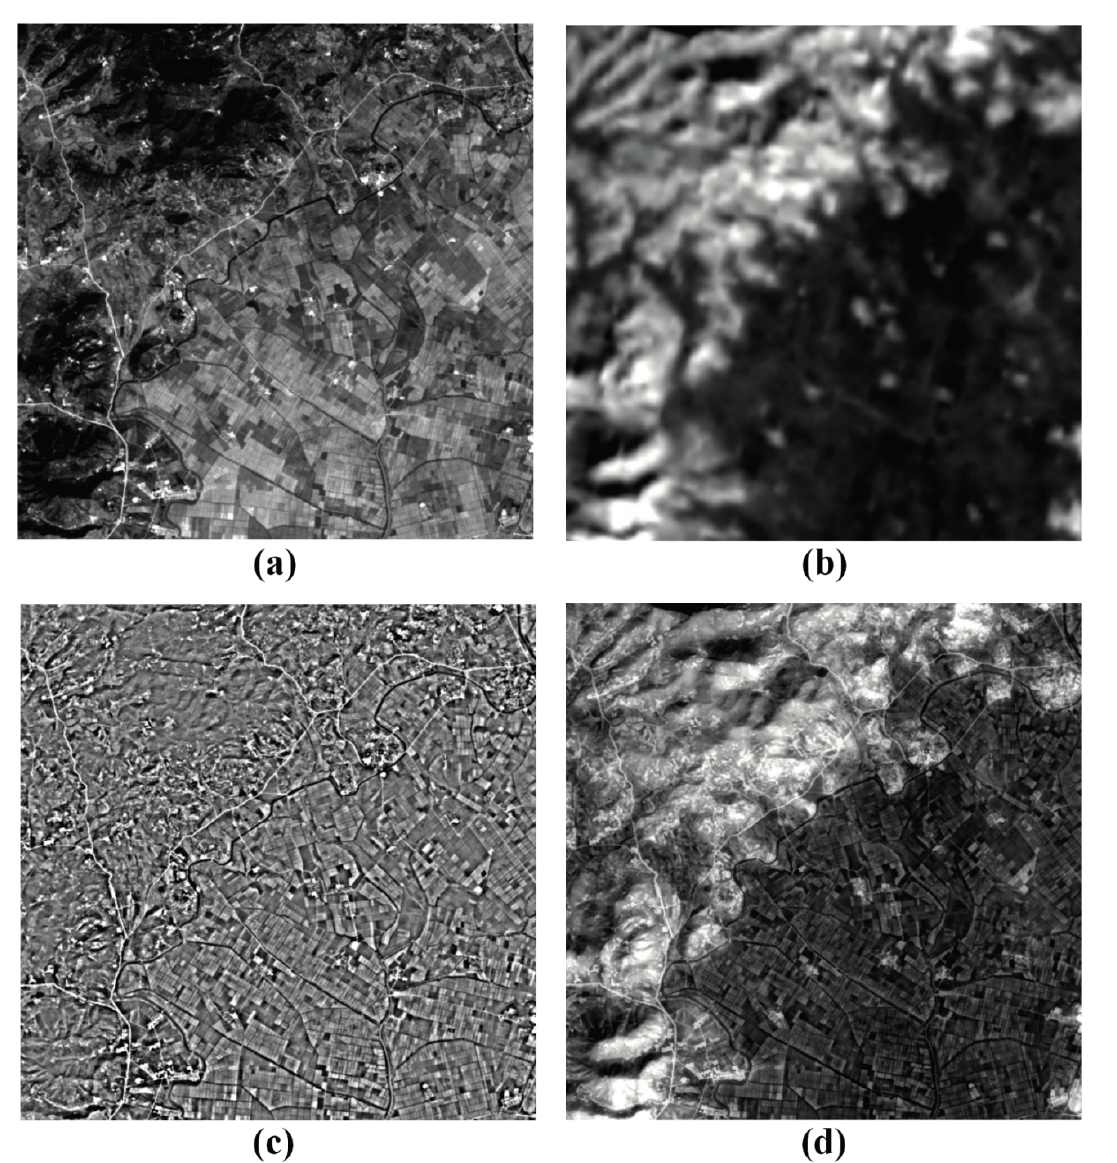
Figure 6. Fused result of the PAN and TIR images obtained from rural areas: ( a ) the PAN and ( b ) TIR images; ( c ) the HP PAN image and ( d ) the fused